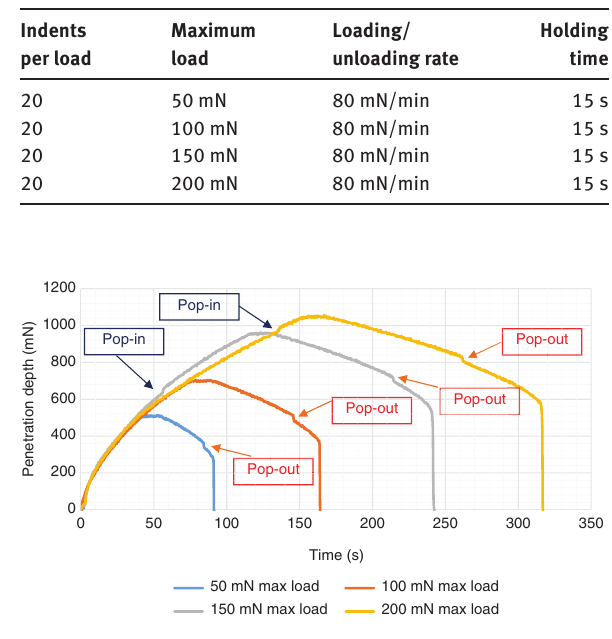
Table 1: Experimental parameters.